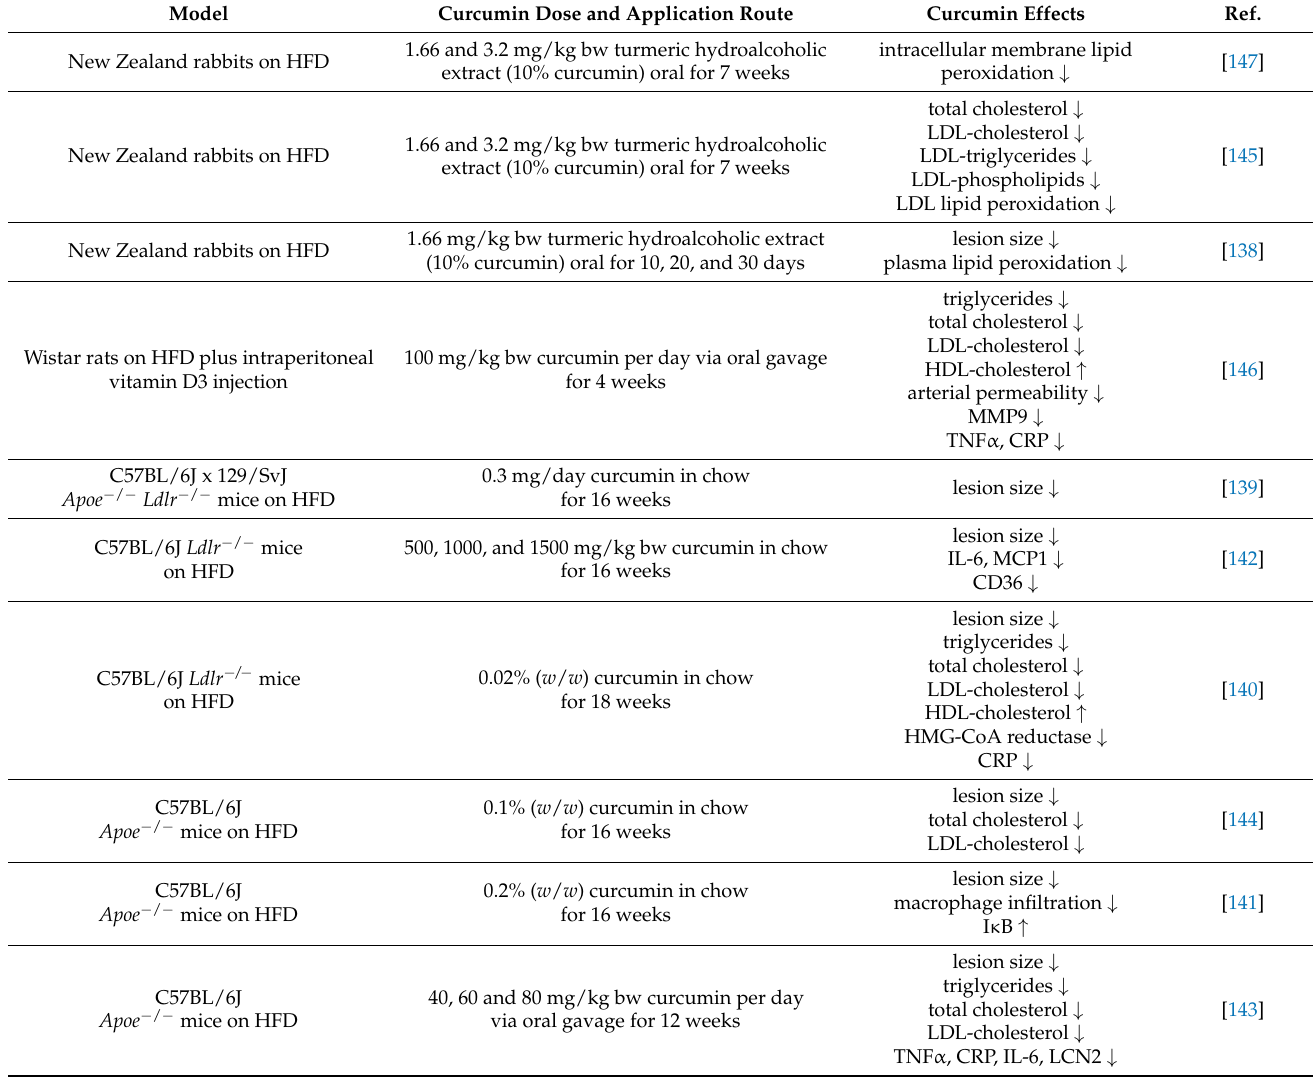
Table 1. Curcumin effects in animal models for